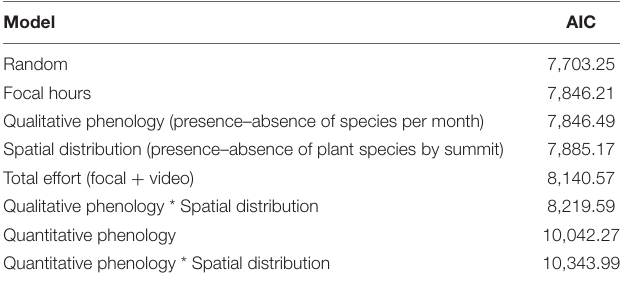
TABLE 3 | Processes related to the network structure through Akaike’s information criterion (AIC) models; they are ordered from smallest to largest.